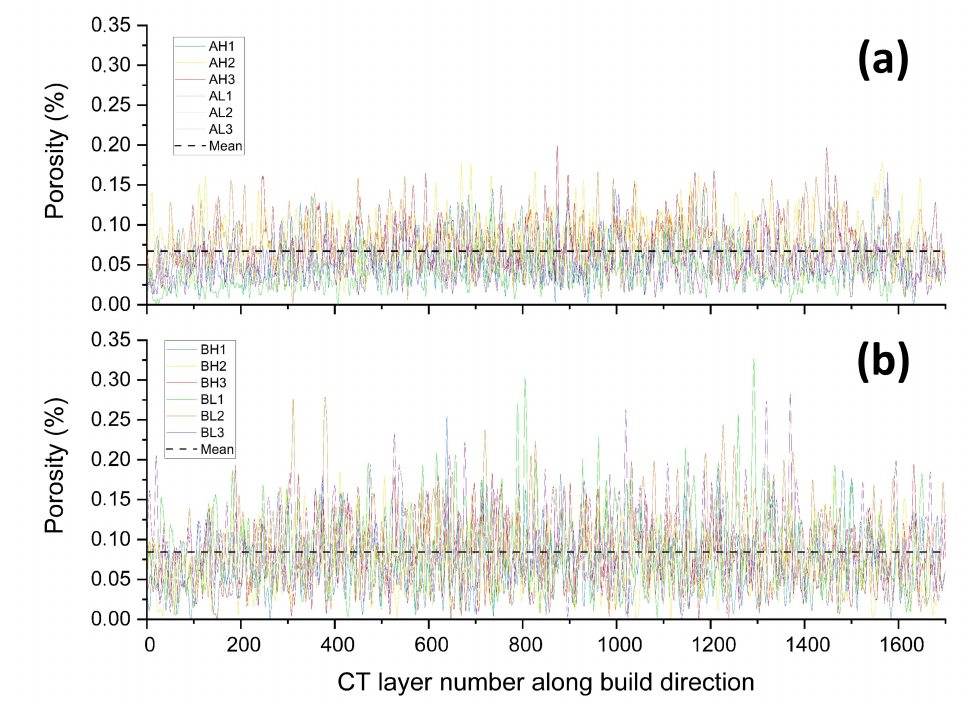
Figure 8. Porosity fraction along the building direction derived from XCT data for each build. Horizontal dashed lines show the global mean porosity for each build. ( a ) Build A. ( b ) Build B.